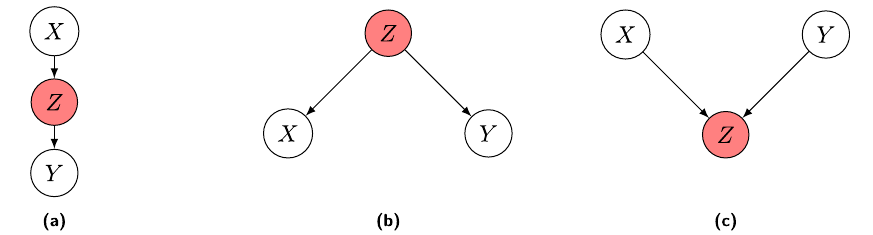
Figure 1: Causal “ triplets ” demonstrating the rules of conditional independence from the d - separation criterion. ( a ) Chain, ( b ) fork, and ( c )